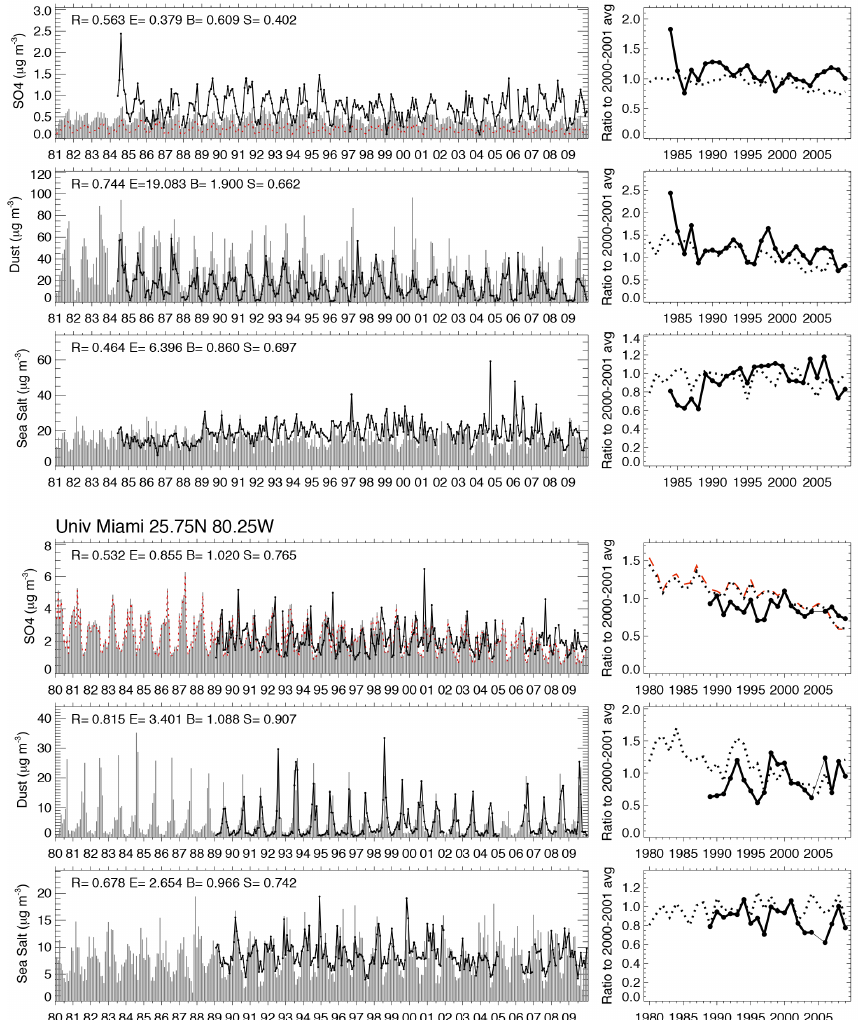
Fig. 10a. Left column: monthly averaged surface concentrations (µgm − 3 ) of non-sea-salt sulfate, dust, and sea salt from 1980 to 2009 at Barbados in North Atlantic (top three rows) and Miami on the coast of Florida (bottom three rows). Data from the University of Miami network. Observations are shown in black lines and the model results in grey bars for total amount and dotted red lines for FF + BB amount. Statistical measures ( R , E , B , and S ) are defined as the same as in Fig. 8a caption. Right column: corresponding ratio of annual mean concentrations to the 2000–2001 average showing the interannual variability/trend over the 20-year period with the observation and models in solid and dotted lines, respectively. Thin solid black line in the right column connects the points with missing year(s) in between for visual